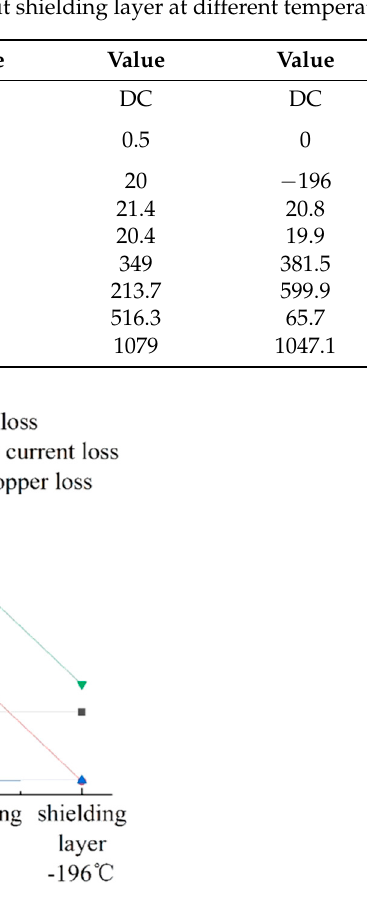
Figure 14. Comparison diagram of motor loss with and without shielding layer at different temper- atures.